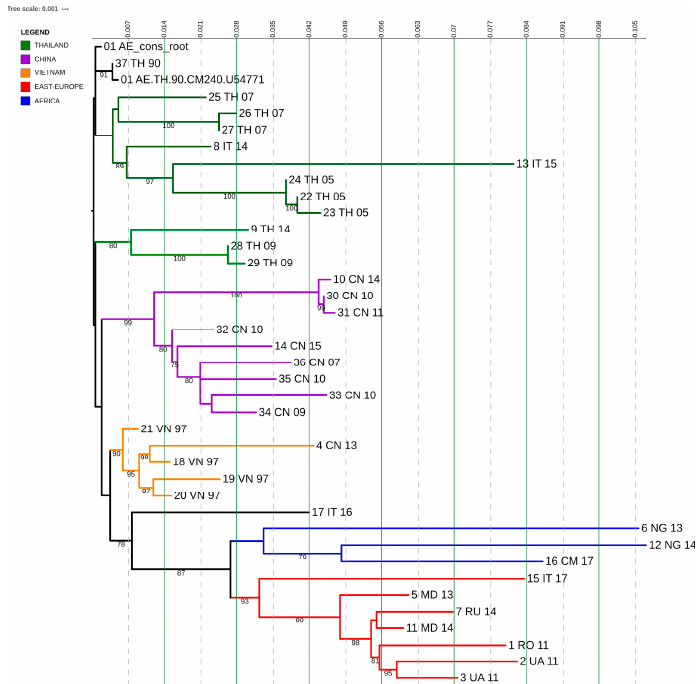
Figure 7. Phylogenetic inference derived from sequence analysis of the subtype CRF01_AE. Maximum likelihood phylogenetic tree was built by using the iq-tree software and displayed via i-Tol. The substitution model used was GTR + G + I, with 1000 replicates in bootstrap analysis. Branch support values are shown for each tree, consisting of related bootstrap proportions. Compressed clades represent the control group for correct phylogeny inference.